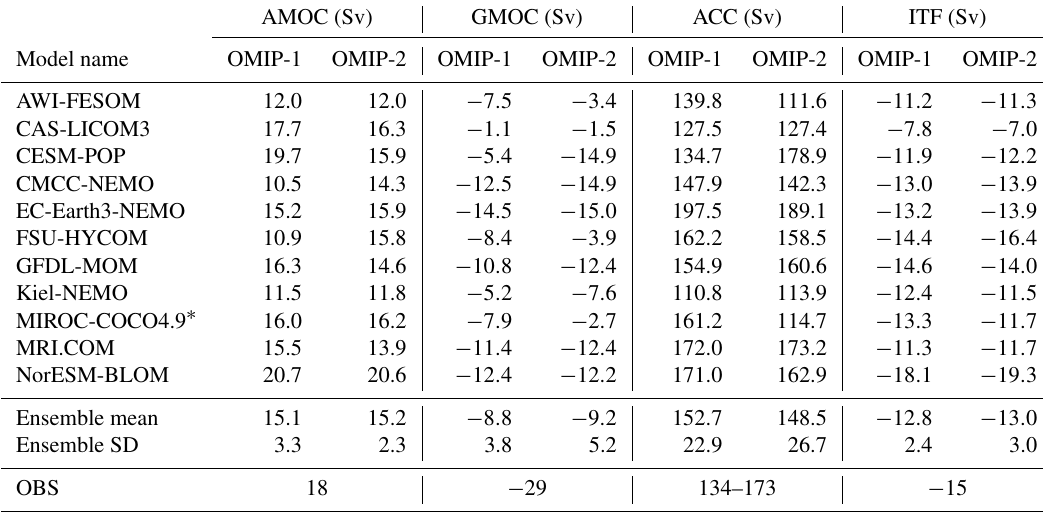
∗ For MIROC-COCO4.9, the fifth cycle is used for both OMIP-1 and OMIP-2.